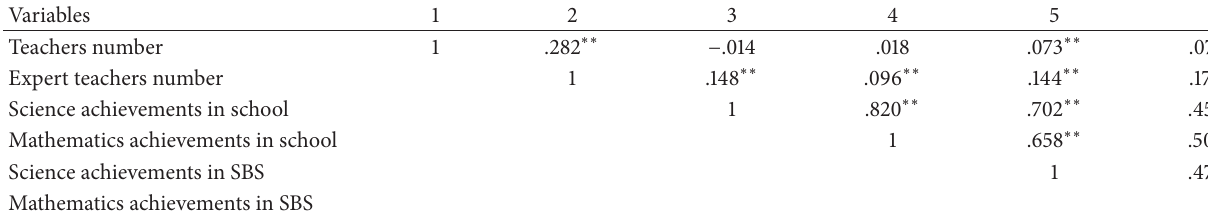
Table 3: Correlations belonging to variables used in the model.